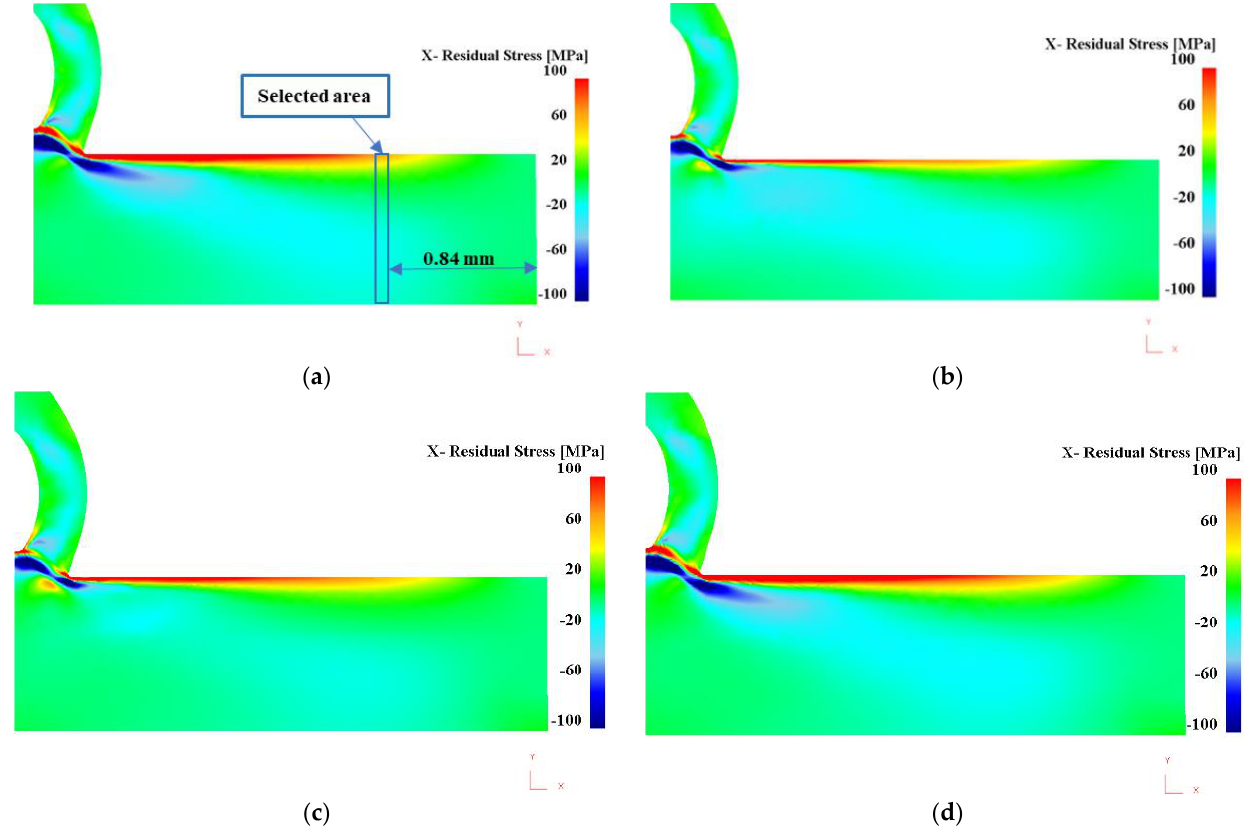
Figure 22. Simulation results of residual stresses measurement in the workpiece depth (r ε = 20 µm and γ = 17.5°): ( a ) 2 ° , ( b ) 7 °, ( c ) 11°, and ( d ) 17.5°.